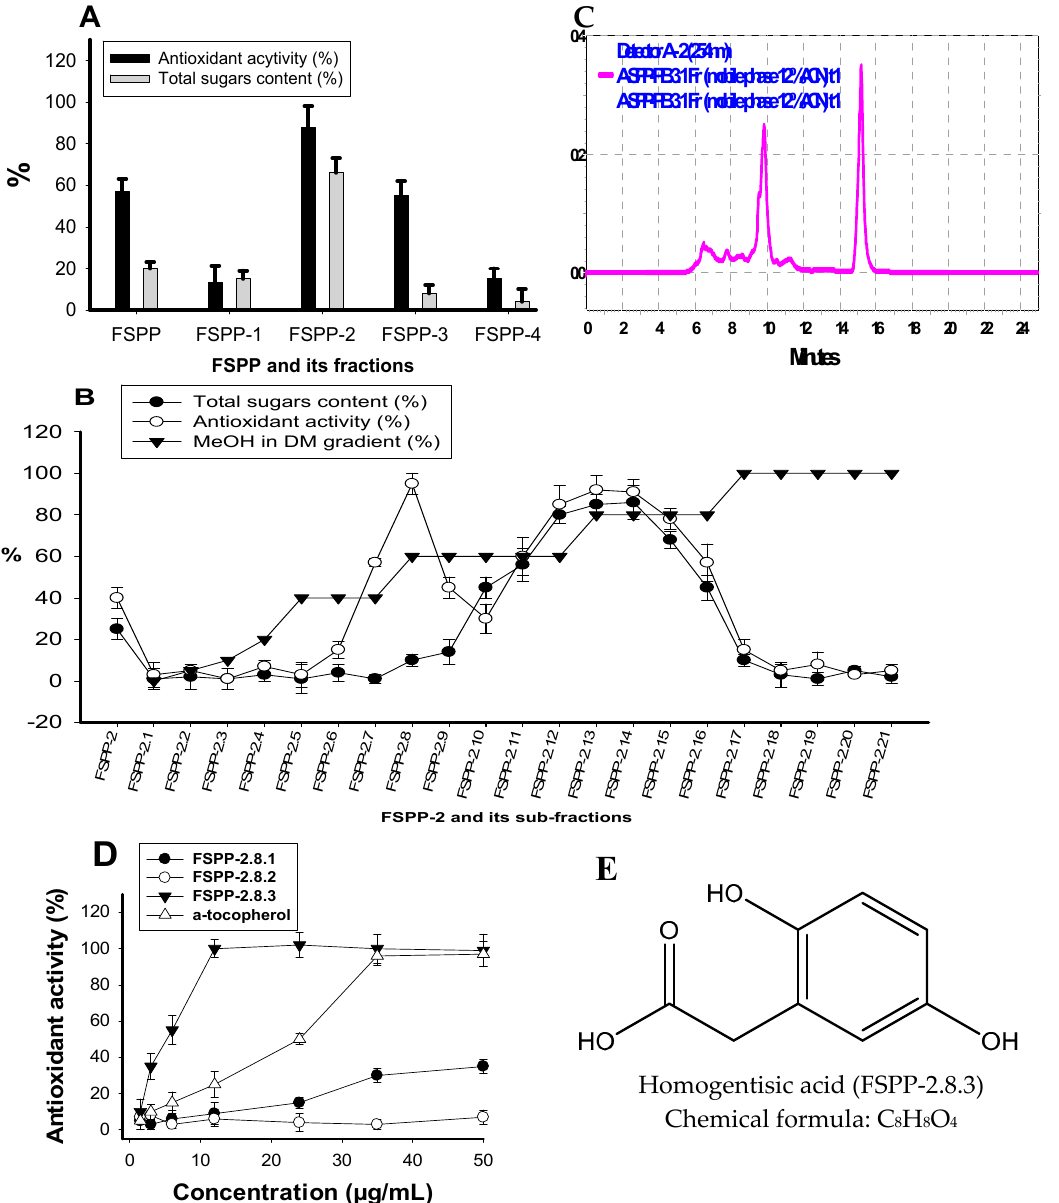
Figure 4. Antioxidant activity and total sugar content of fractions, sub-fractions and compounds after ( A ) Diaion opened column, ( B ) silica gel opened column, and ( D ) preparative HPLC column, respectively; ( C ) the HPLC finger prints of FSPP-2.8.1, FSPP-2.8.2, and FSPP-2.8.3 with the retention times at 6.5 min, 9.8 min, and 15.2 min, respectively; and ( E ) the chemical formula, structure of homogentisic acid.